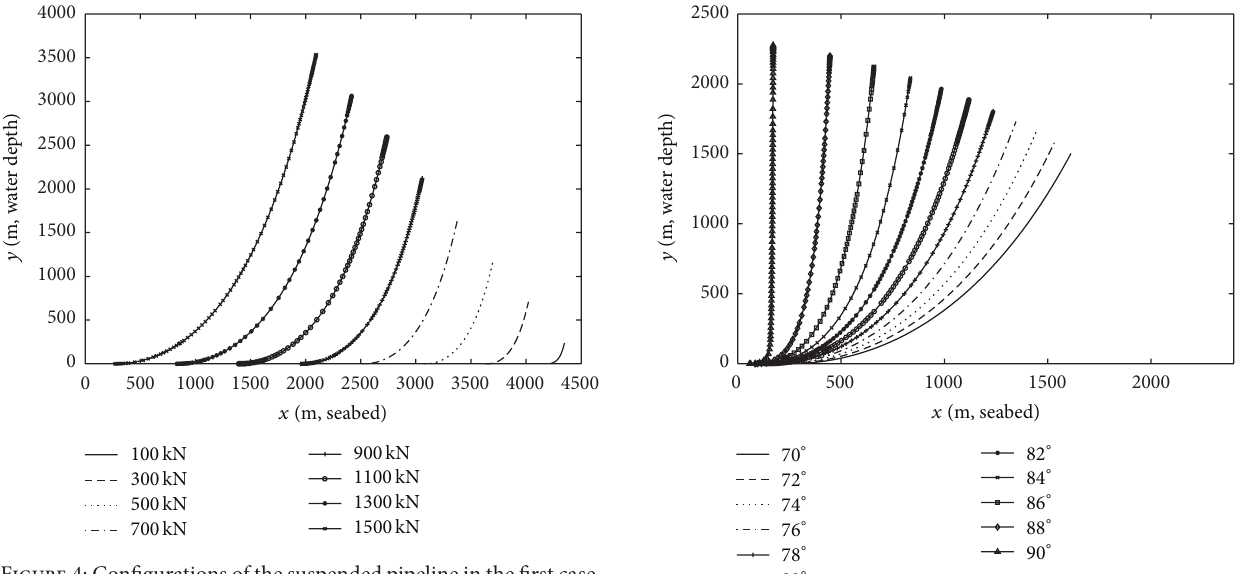
Figure 4: Configurations of the suspended pipeline in the first case.